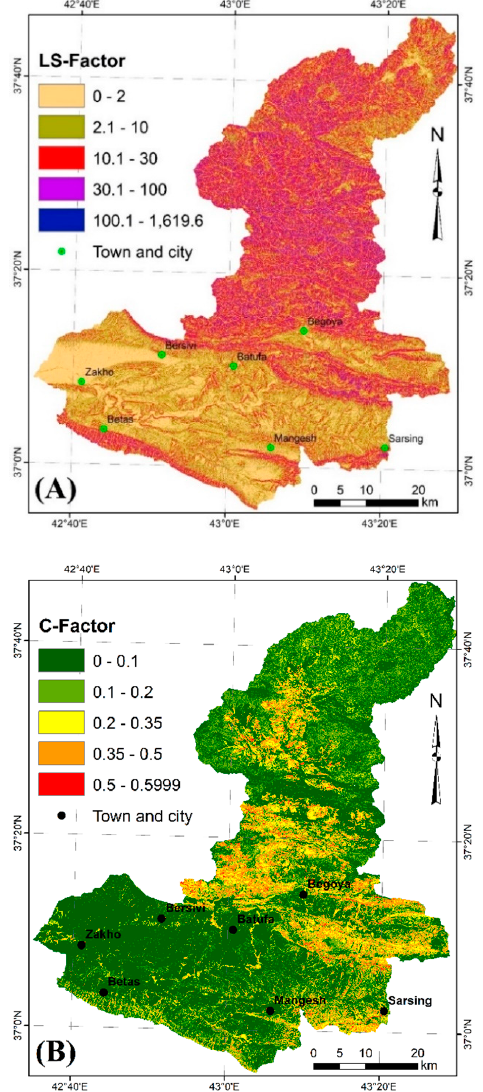
Figure 6. Maps showing distribution of the: ( A ) LS factor, and ( B ) C factor.